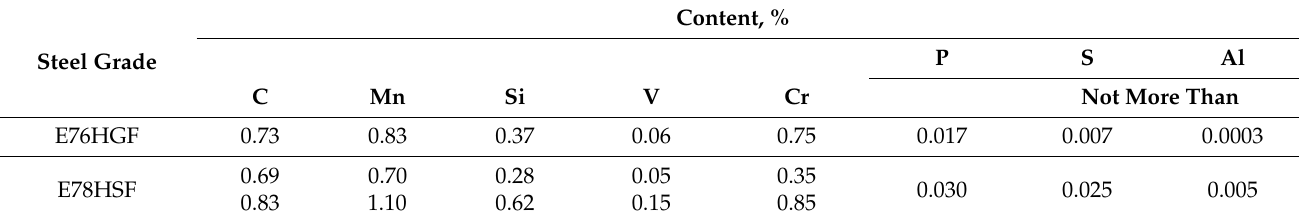
Table 1. Chemical composition of